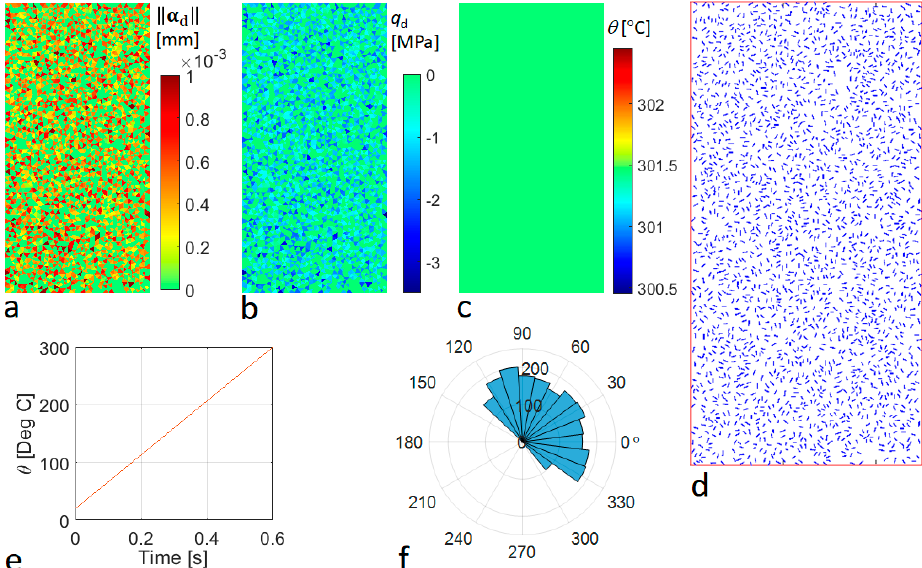
Figure 4. Simulation results for heat treatment (300 ◦ C, NumRock1): ( a ) crack opening magnitude; ( b ) stress-like softening variable; ( c ) temperature field; ( d ) thermally induced cracks; ( e ) temperature evolution in time; ( f ) polar histogram showing crack orientation angles (2186 cracks).